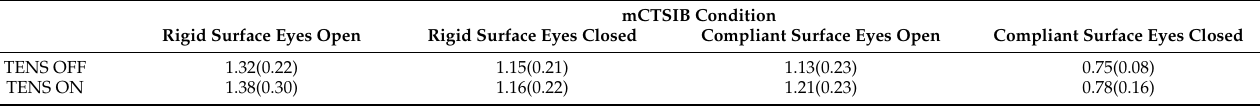
Table 2. The VTC results for mCTSIB balance conditions with and without